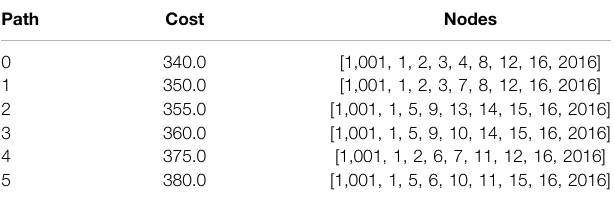
TABLE 3 | Considered paths of the test network.